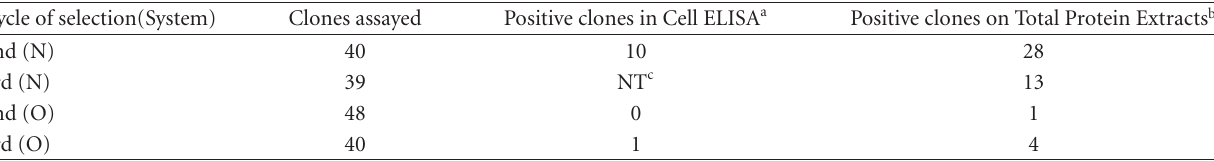
Table 1: Reactivity of randomly selected Fabs toward tumor antigens in ELISA